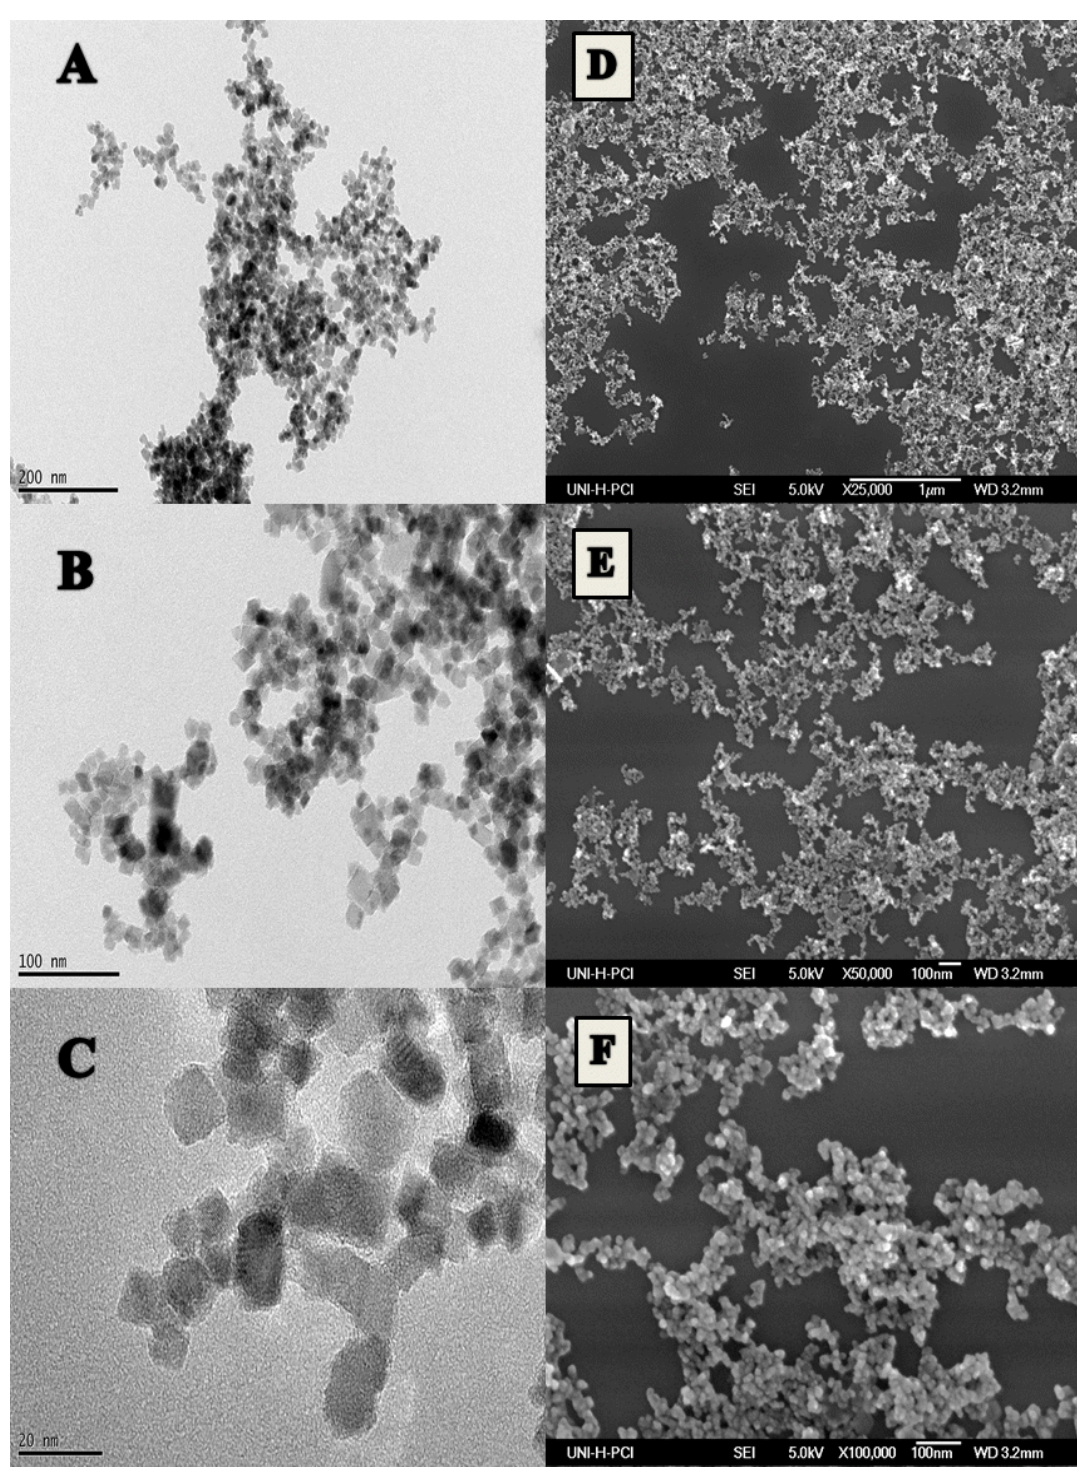
Figure 2. Images of the synthesized iron oxide nanoparticles at different magnifications by ( A – C ) a transmission electron microscope (TEM) and ( D – F ) a scanning electron microscope (SEM).